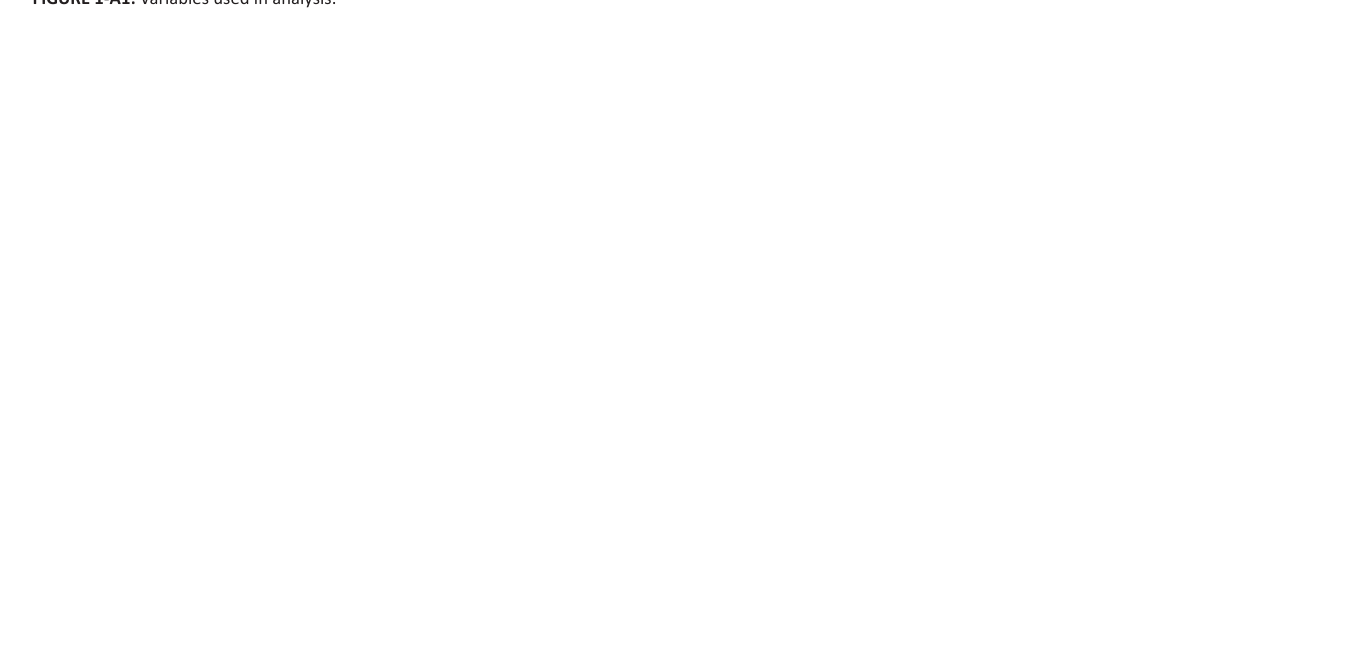
FIGURE 1-A1: Variables used in